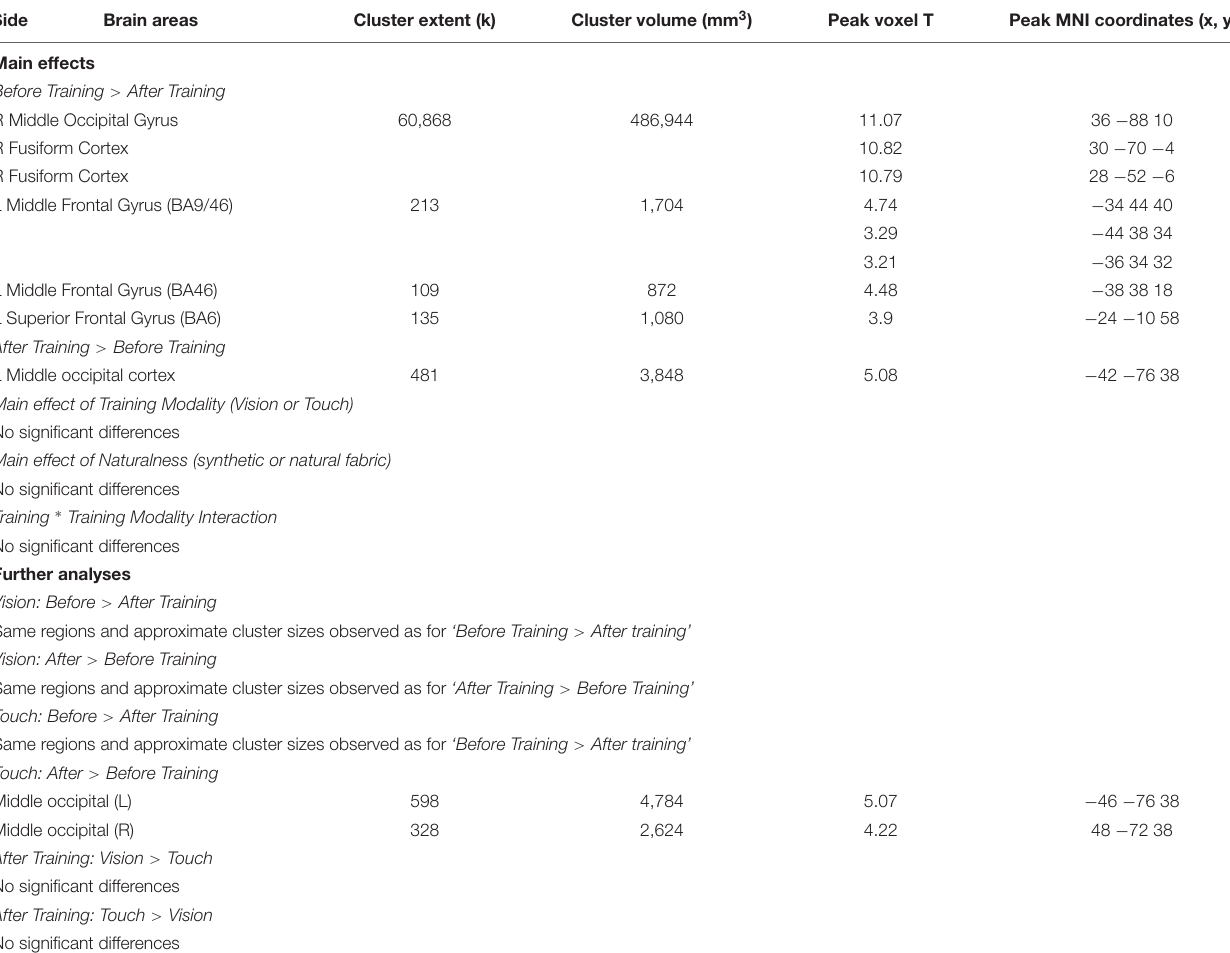
TABLE 1 | Summary of the results of the whole brain analysis visual categorisation task (before vs. after training), training modality (within vs. across modality) and naturalness (synthetic vs. natural) as factors. Side Brain